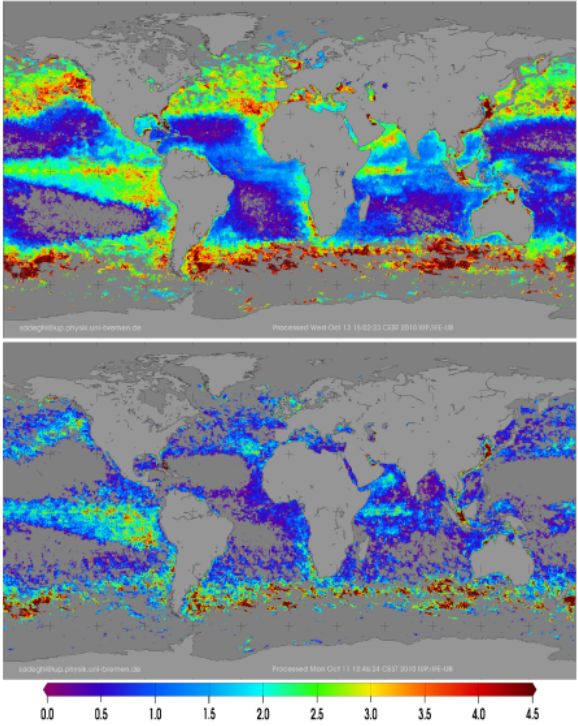
Fig. 2. Global fit factor maps [mgchlm − 2 ] for E. huxleyi in March 2005, obtained by single-target fit (upper panel) and triple-target fit (lower panel) modes of PhytoDOAS using SCIAMACHY